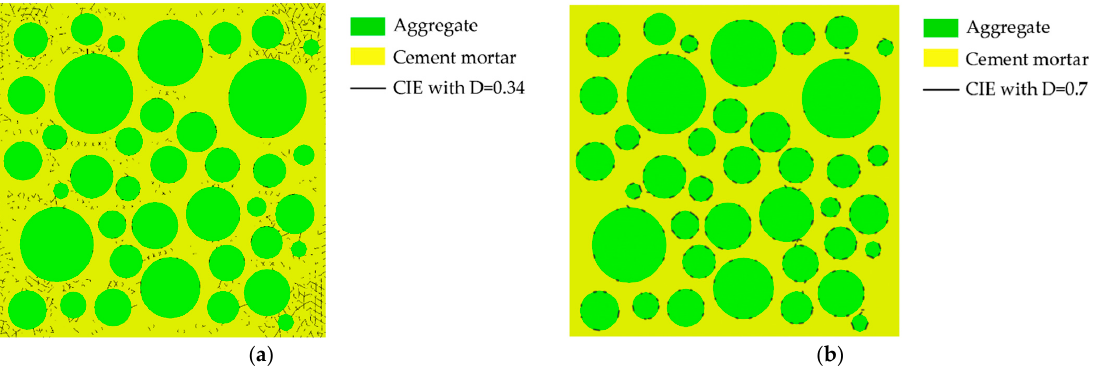
Figure 7. The distribution of CIEs with D = 0.34 and D = 0.7 when σ / σ max ≈ 0.74. ( a ) D = 0.34; ( b ) D = 0.7. 3. The unstable development stage of cracks (0.75~0.9 < σ / σ max ).